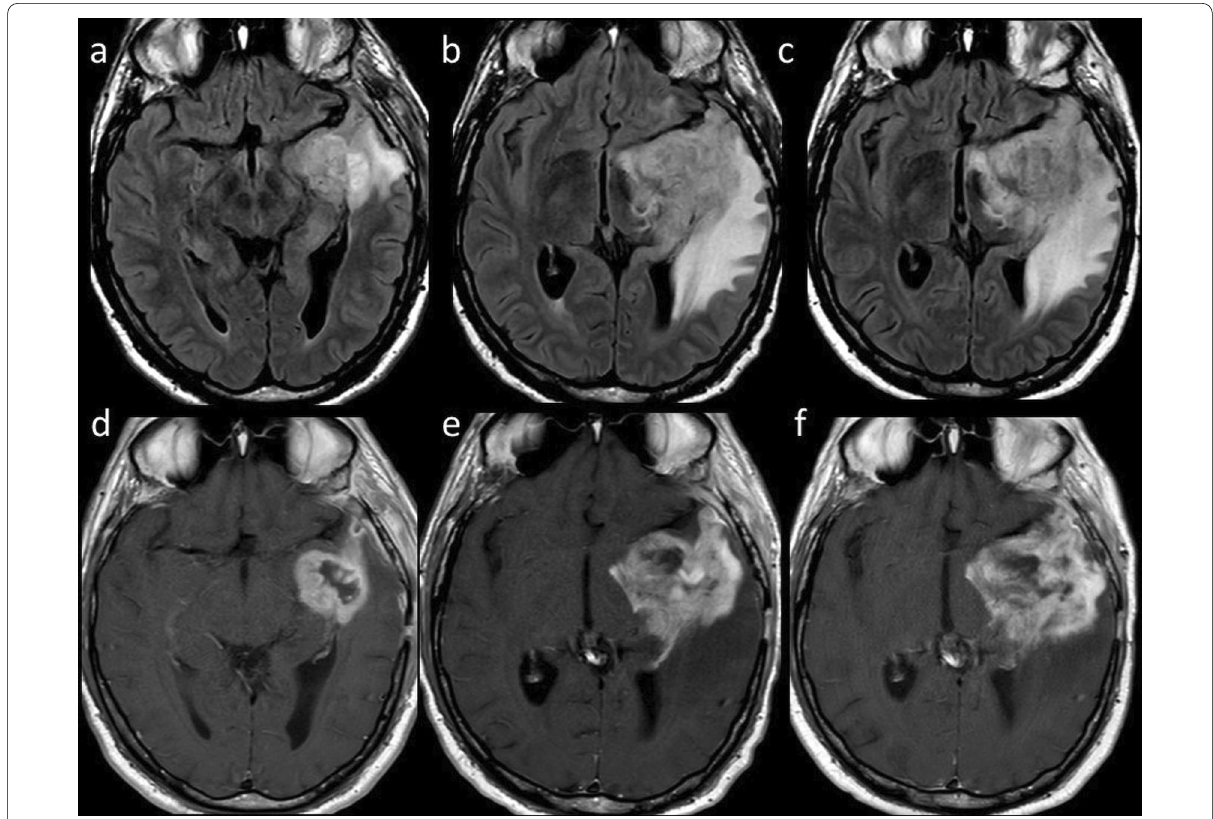
Fig. 2 True progression. 53-year-old man with glioblastoma treated with surgery, ChT and RT. Axial FLAIR (upper row) and contrast-enhanced T1-weighted (lower row) 1 month after surgery ( a , d ), and 1 ( b , e ) and 4 ( c , f ) months after ChT/RT showed continuous increasing in signal changes and enhancement of the